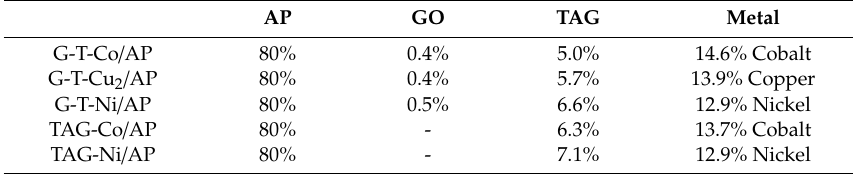
Table 1. The compositions of ammonium perchlorate (AP)-based mixtures (in weight